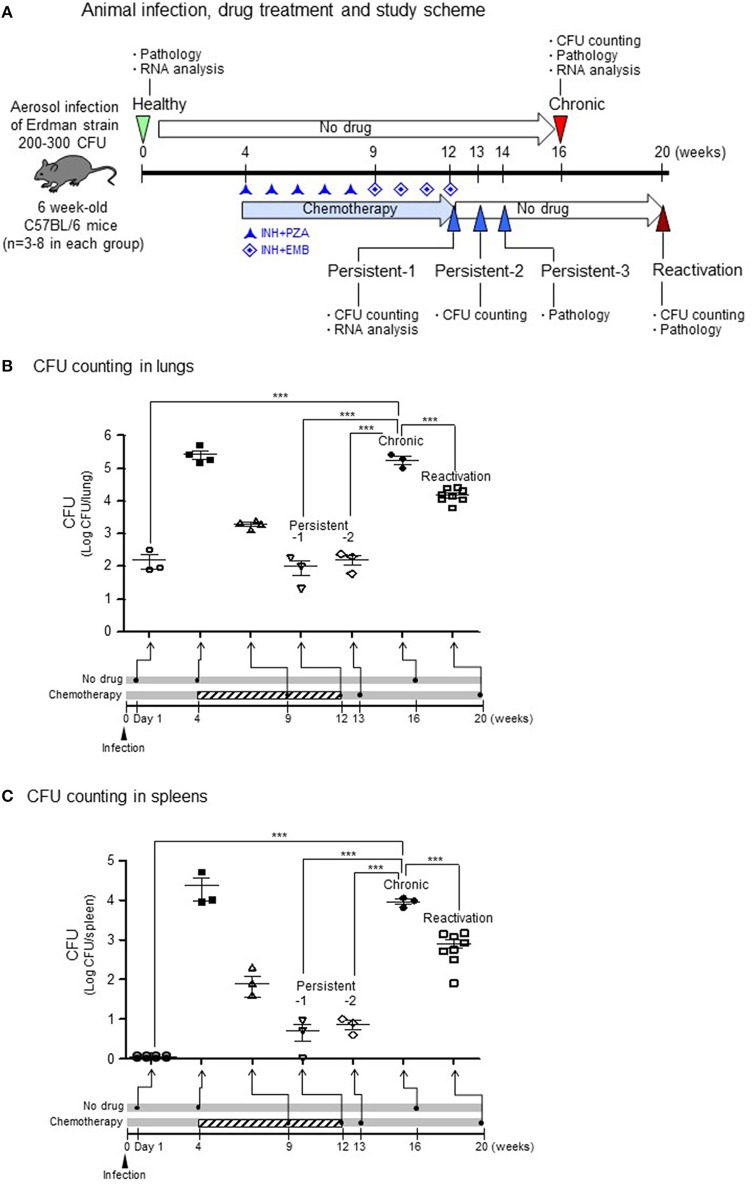
CFU in lungs or spleens after aerosol infection with M. tuberculosis bacilli.(A) Experimental design for TB infection. For the chronic stage, mice were not treated with any anti-TB agents for 16 weeks after aerosol infection of 200–300 colony-forming units (CFU). For the persistent infection, isoniazid (INH) and pyrazinamide (PZA; from the 4th to 9th weeks) and INH and ethambutol (EMB; from the 9th to 12th weeks) were administrated after aerosol infection. For the reactivation, the persistent stage mice were no longer treated with anti-TB agents (from the 12th to 20th weeks). (B,C) The lungs and spleens from each stage were homogenized in PBS, and dilutions were plated on 7H10 agar to enumerate CFUs. N = 2–8 in each group. One-way ANOVA was used for statistical analysis. ***p < 0.001.